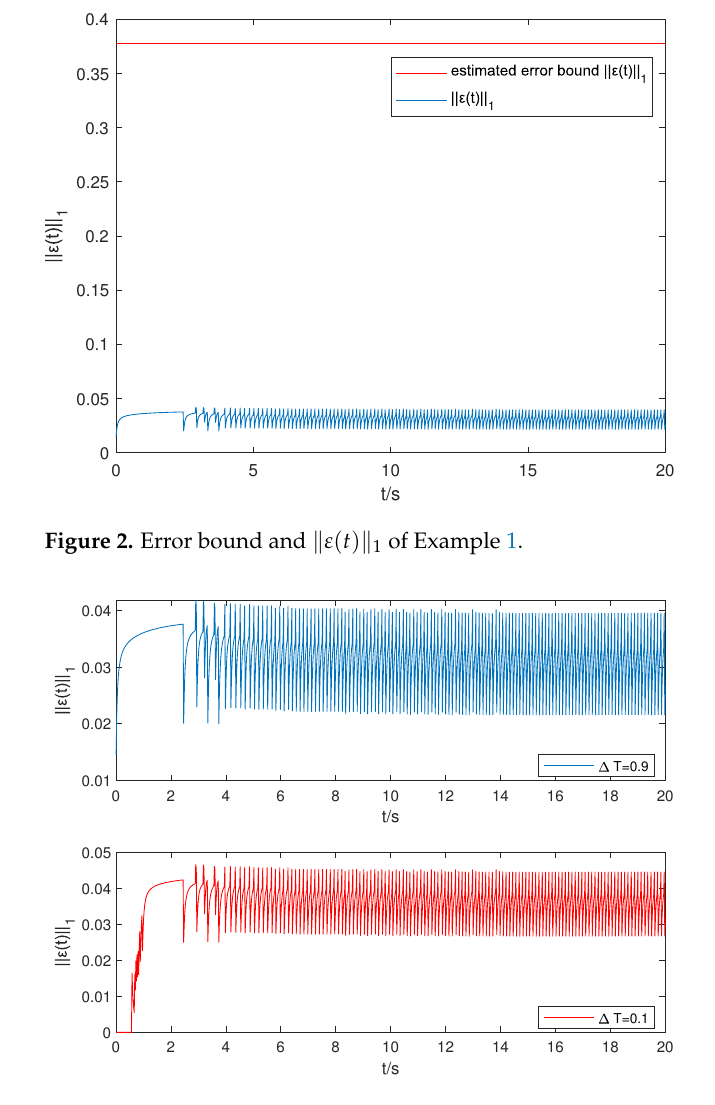
Figure 3. (cid:107) ε ( t ) (cid:107) 1 with different ∆ T